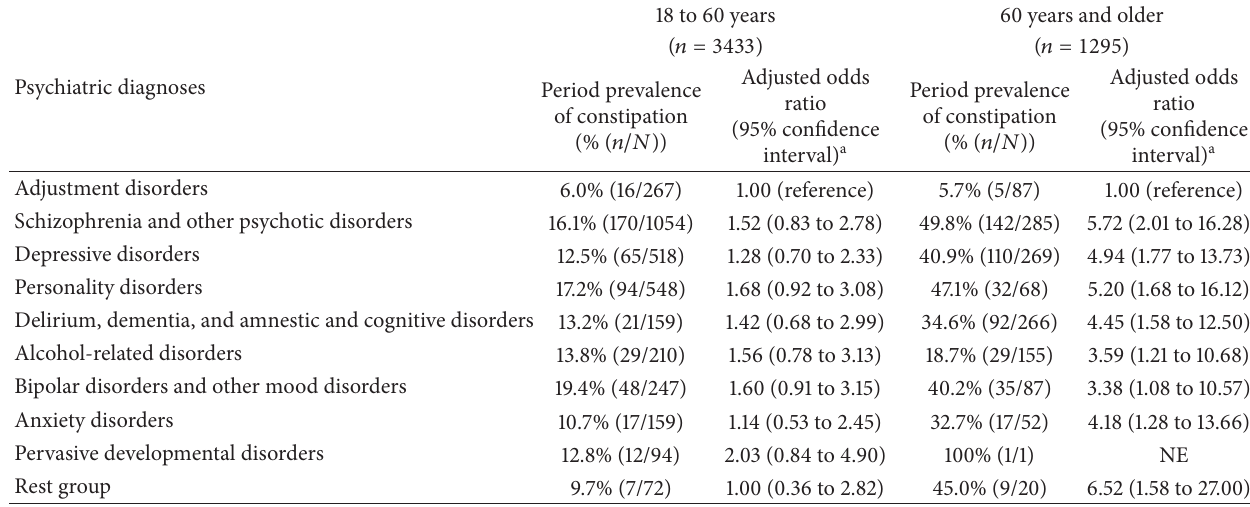
Table 1: The association between psychiatric diagnoses and constipation (stratified for